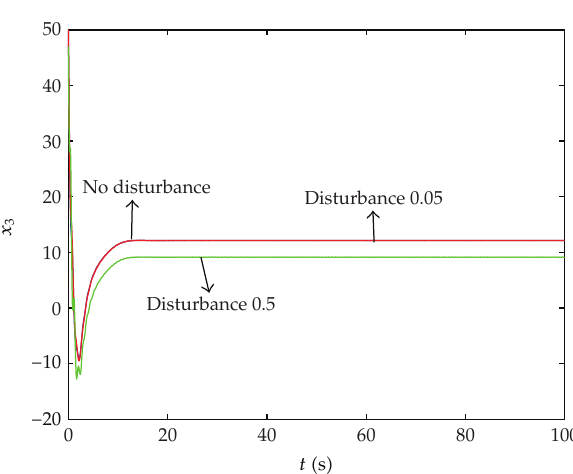
Figure 11: Trajectories of the state variable x 3 by T1ABFC with external